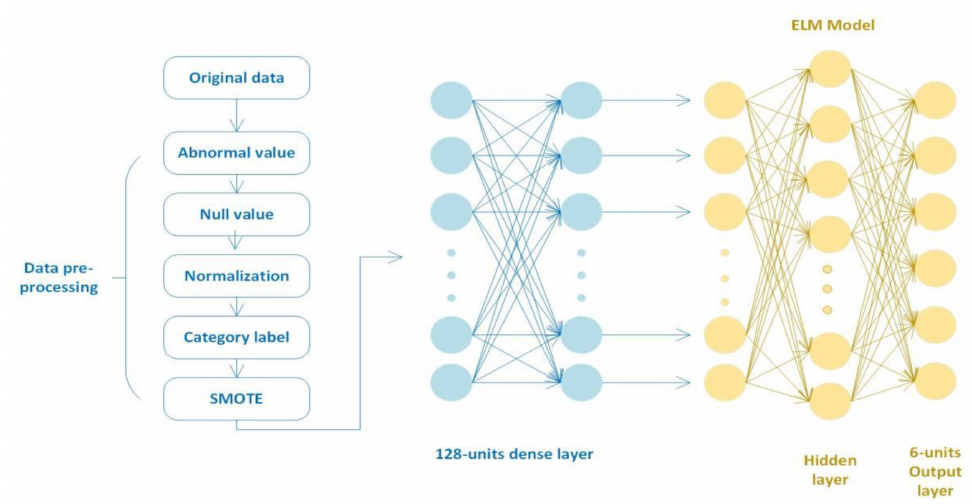
Figure 8. Flow chart of extended ELM